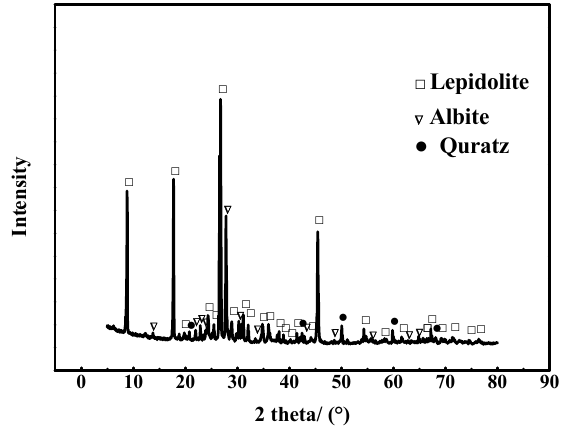
Figure 2. XRD pattern of lepidolite concentrate powder.